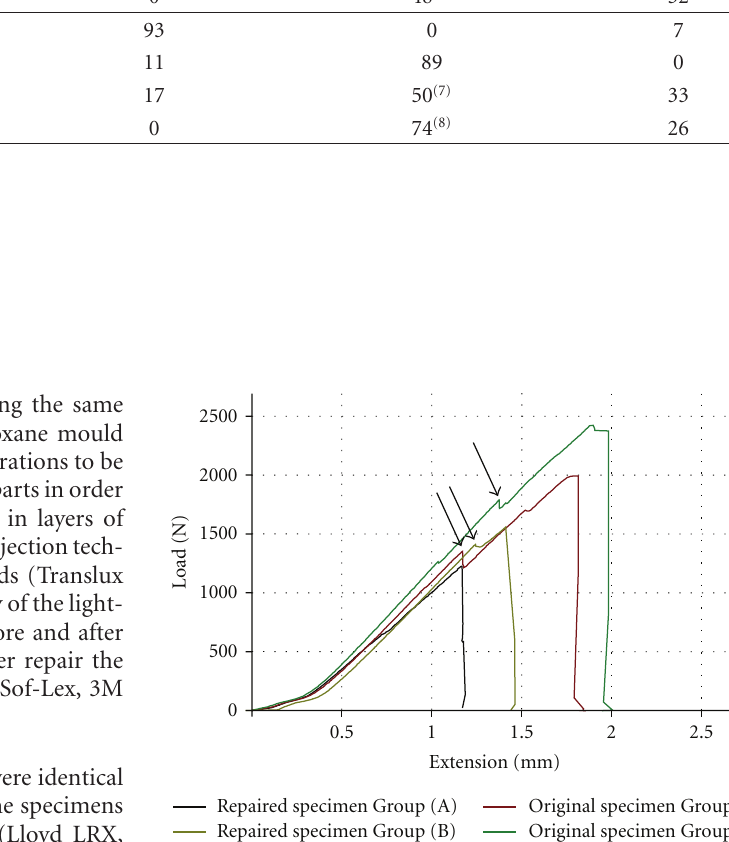
Figure 3: Representative fracture graphs from the repaired and the original specimens (arrows indicate initial